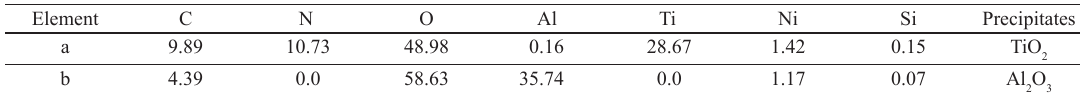
Table 7. Chemical constituents of precipitated phases (at. %)